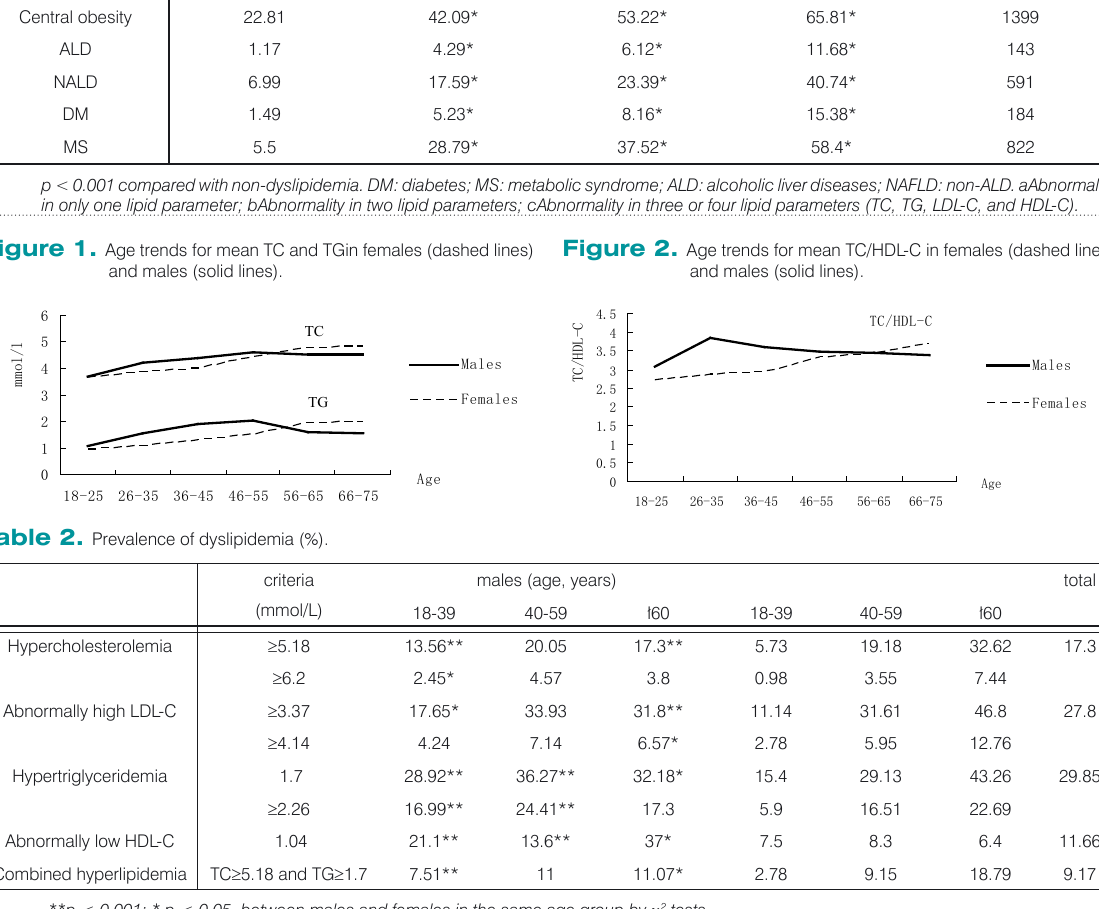
Table 1. The prevalence of diseases in different groups of serum lipid abnormality.